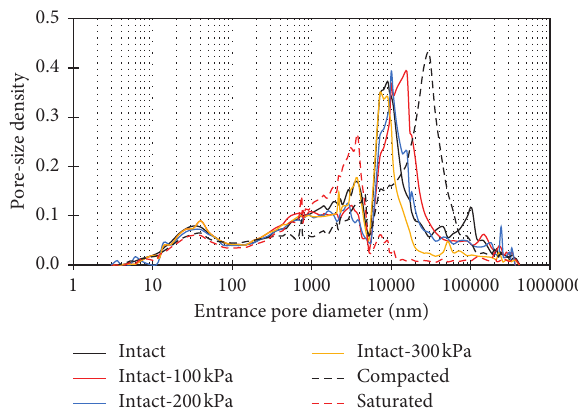
Figure 7: PSDs of intact loess specimens consolidated to various confining stresses.